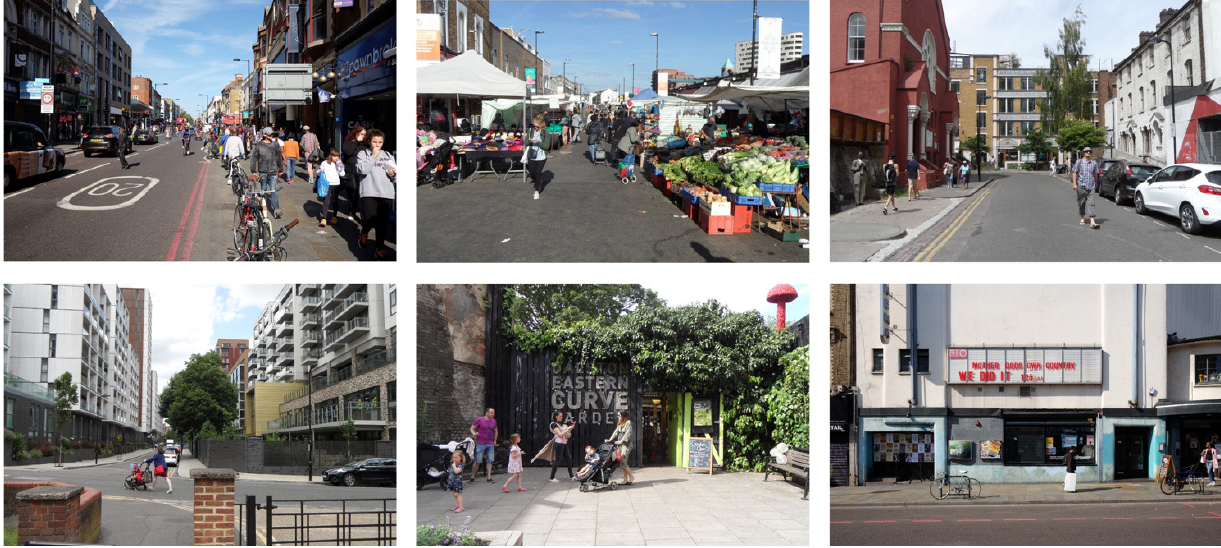
Figure 2. Dalston town centre in 2017–2018. From top left to right: Kingsland High Street, Ridley Road Market, Ashwin Street, Dalston Square development, Dalston Eastern Curve Garden, and Rio